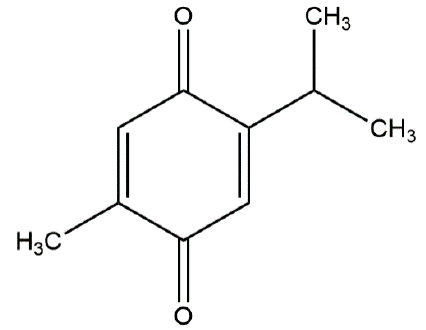
Figure 9. Chemical structure of thymoquinone.